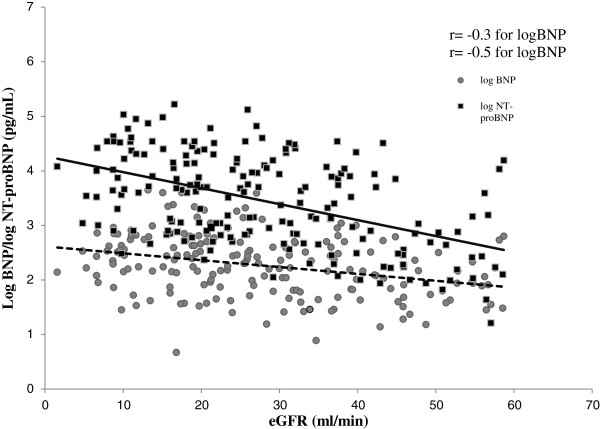
Scatter plot of log transformed plasma B-type natriuretic peptide (BNP) and amino terminal B-type natriuretic peptide (NT-proBNP) in relation to estimated glomerular filtration rate (eGFR). Lines of best linear fit are drawn.